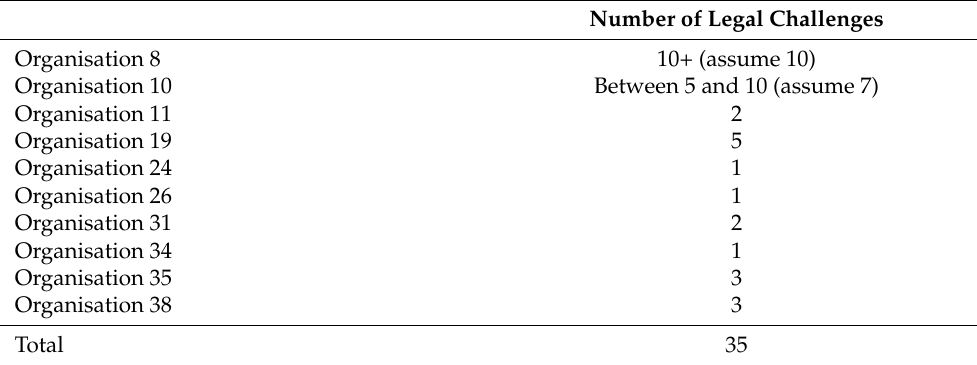
Table 7. No. of challenges beyond informal le tt er.